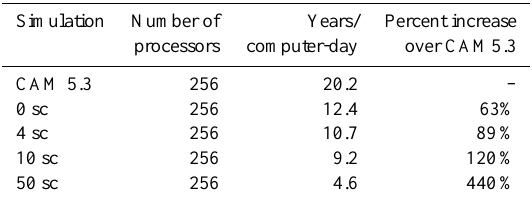
Table 2. Computational cost of CAM 5.3 and CAM-CLUBB– SILHS simulations.